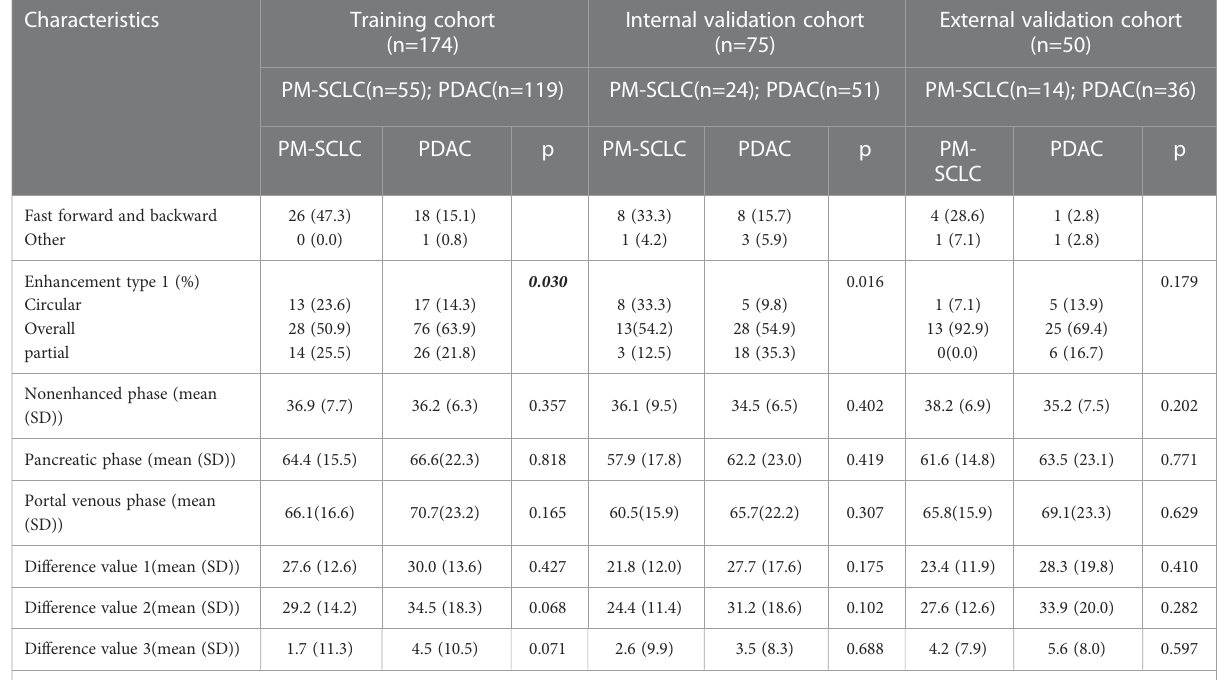
was created based on the best logistic model, which was built by using the extended logistic regression method penalized with LASSO with 10-fold cross-validation from the established optimal feature subsets of the training cohort (Figure 6). The calibration curves of the combined nomogram showed good calibration performances in the training cohort, internal validation cohort, and external validation cohort, the high agreements between ideal curves and calibration curves were nomogram showed good discrimination between PM-SCLC and